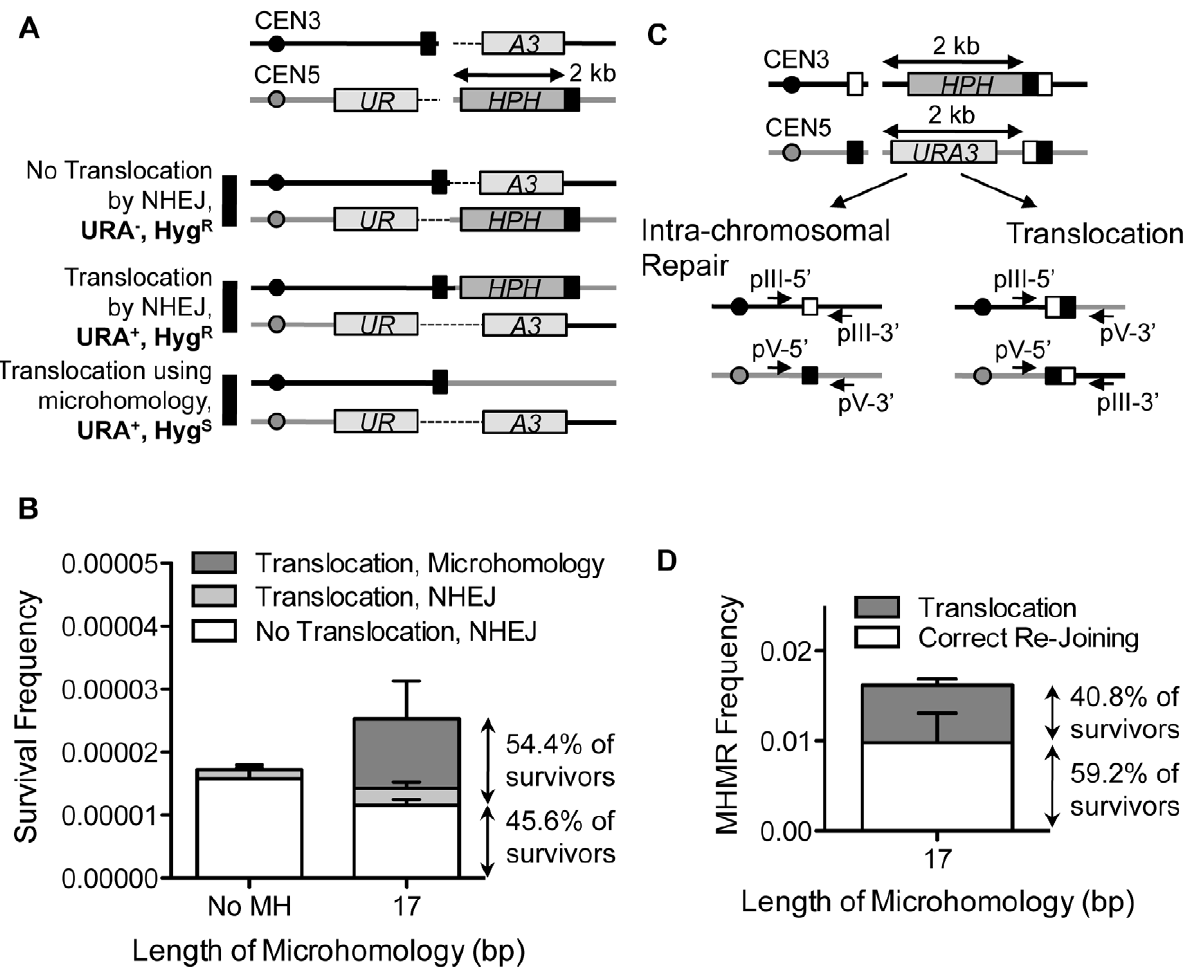
Figure 5. MHMR stimulates HO break-induced chromosomal translocations. (A) Diagram of the strain with one HO recognition sequence on chromosome III and one HO recognition sequence on chromosome V. 17 bp of microhomology (shown in black box) found on the centromeric side of the DSB on chromosome III is also found on the telomeric side of the DSB on chromosome V, 2 kb from the break site. In this strain, one part of the URA3 gene ( UR ) is found on the centromeric side of chromosome V, and the other part of the URA3 gene ( A3 ) is found on the telomeric side of chromosome III. Since artificial introns (the dotted lines) are inserted between the gene and the HO cut-site, the URA3 gene is expressed in the event of reciprocal translocation. Three possible repair outcomes are shown at the bottom. (B) The frequencies of the repair outcomes from the yeast strain with breaks on two different chromosomes are shown. Survival frequency was calculated as shown in Figure 1B. The results are the average of three independent experiments 6 S.D. (C) Diagram illustrating the strain that allows for competition between intra-chromosomal and inter-chromosomal MHMR. The positions of microhomology (white and black boxes), and HPH and URA3 markers are shown. The location of sequences homologous to two sets of primers used to check the types of repair events are shown in arrows. (D) Survival frequency of intra- and inter-chromosomal MHMR. Survival frequency was calculated as shown in Figure 1B. The results are the average of three independent experiments 6 S.D. 100 colonies from each survival experiment were assessed by PCR to detect intra-chromosomal or inter-chromosomal repair